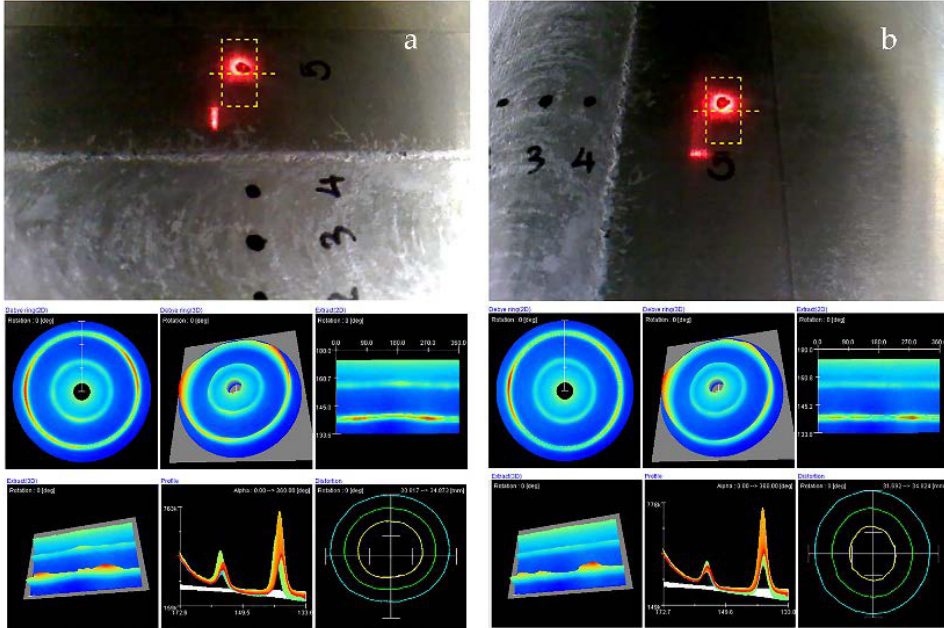
Figure 17. Residual stress measurement for each point: ( a ) transverse direction and ( b ) longitudinal direction .